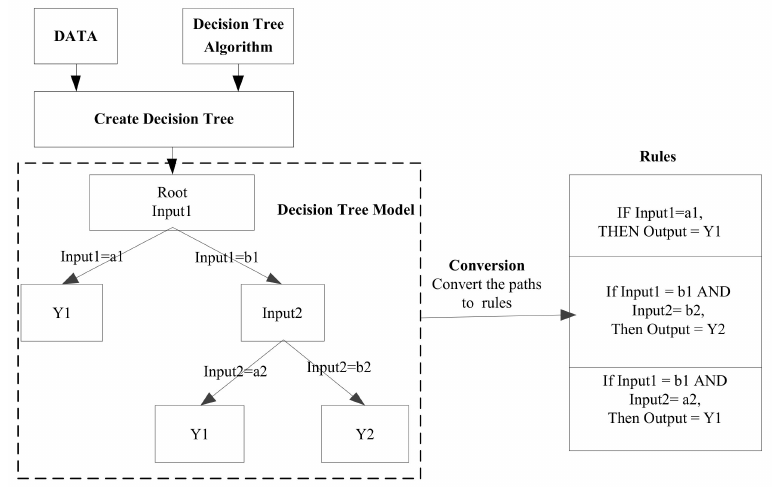
Figure 1. Principle of decision rules extraction based on the decision tree algorithm. Where Input1 and Input2 outputs are variables of the decision tree and a1, a2, b1, b2, Y1 and Y2 are the decision tree